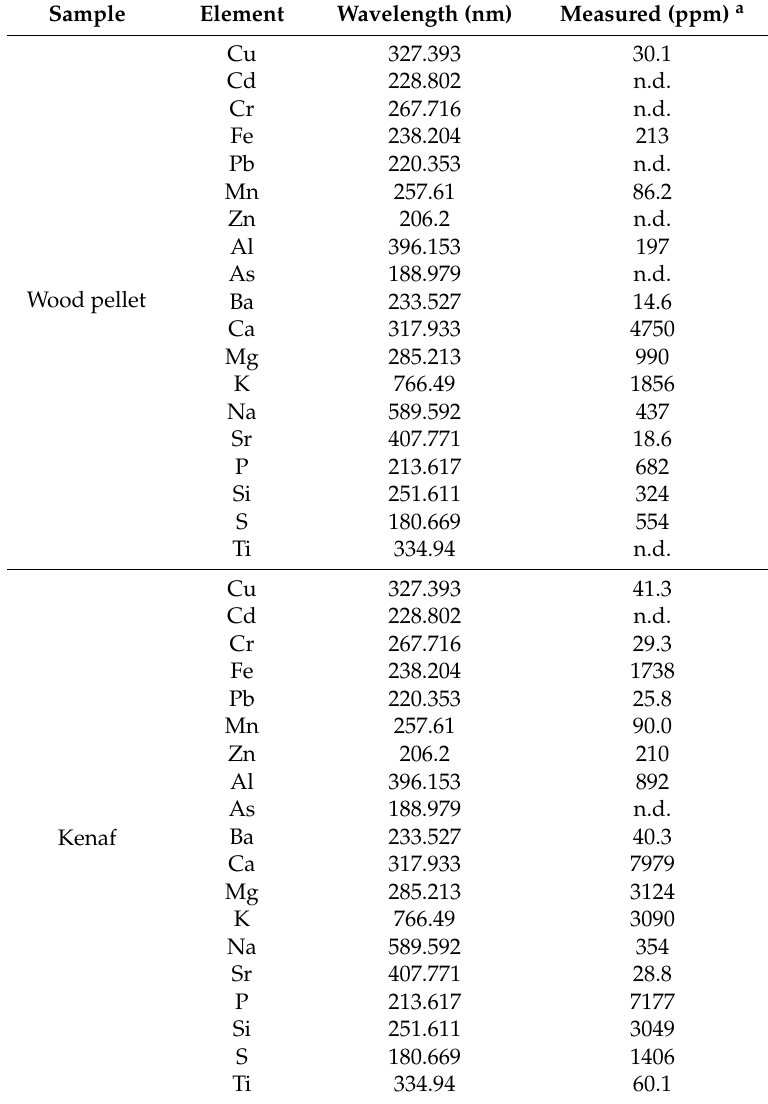
Table 3. Inductively coupled plasma-optical emission spectrometer (ICP-OES) results for the biomass